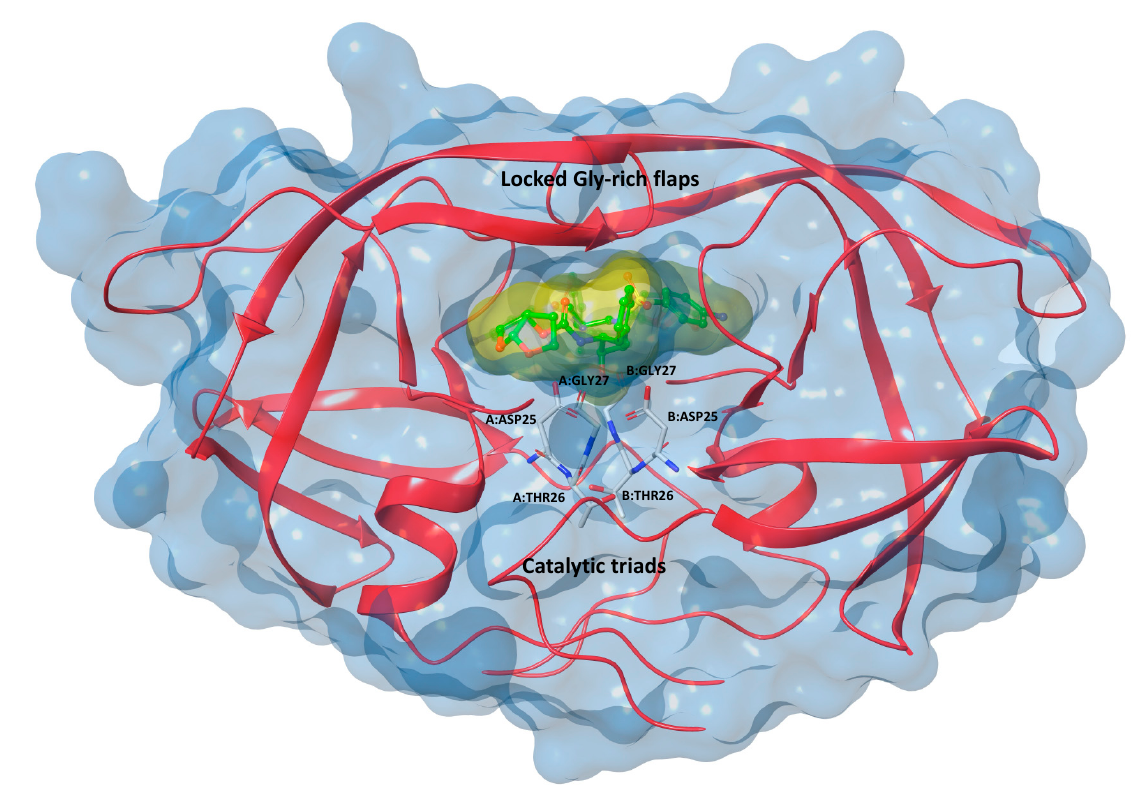
Figure 2. 3D structure of HIV-1 PR in complex with darunavir (PDB id: 2IEN), with the two catalytic triads (Asp 25 , Thr 26 , and Gly 27 ) highlighted [26] .